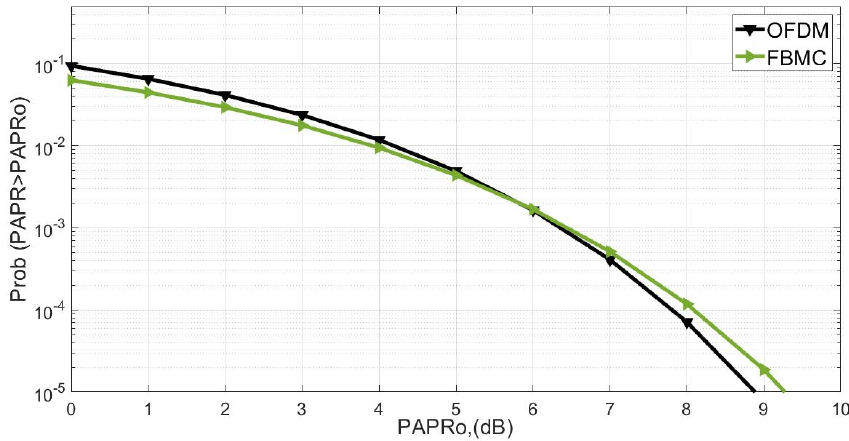
Figure 9. PAPR curves.